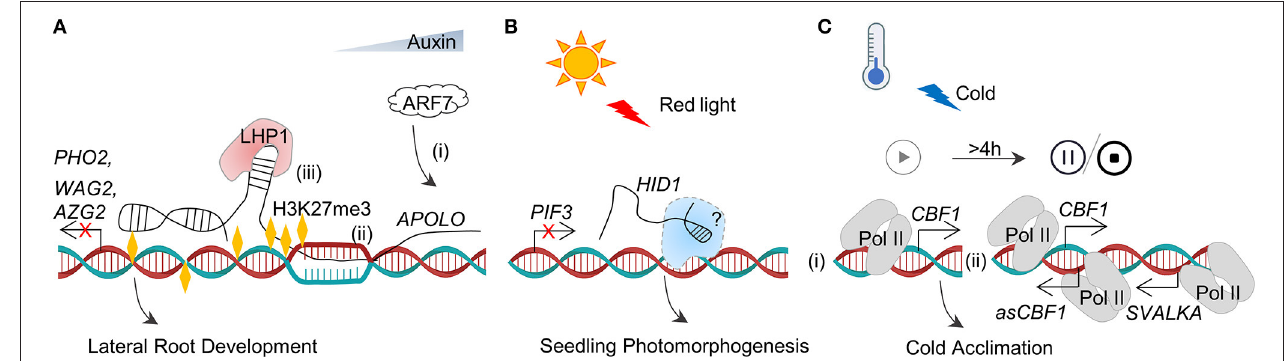
FIGURE 4 | LncRNA–DNA interactions. (A) (i) Upregulation of APOLO by ARF7 after auxin treatment, (ii) direct binding between APOLO and auxin-responsive genes chromatin through base complementarity to form R-loop in cis and trans . Expressions of these auxin-responsive genes contribute to the lateral development, and (iii) recruitment of LHP1 by APOLO to deposit H3K27me3 for closing the loop and then for silencing the APOLO target. (B) HID1 binds to the proximal promoter of PIF3 and represses its expression to modulate seedling photomorphogenesis. HID1 may function by combining with proteins although the detail is still unknown. (C) (i) Sense CBF1 is initiated by cold exposure, and the expression peaks after 4h. (ii) Contemporaneously, SVALKA is induced in the antisense region of CBF1 . RNA Pol II read-through transcription of SVALKA leads to the expression of asCBF1 and an increase of RNA Pol II occupancy on strands. The collision of RNA Pol II stalls CBF1 sense